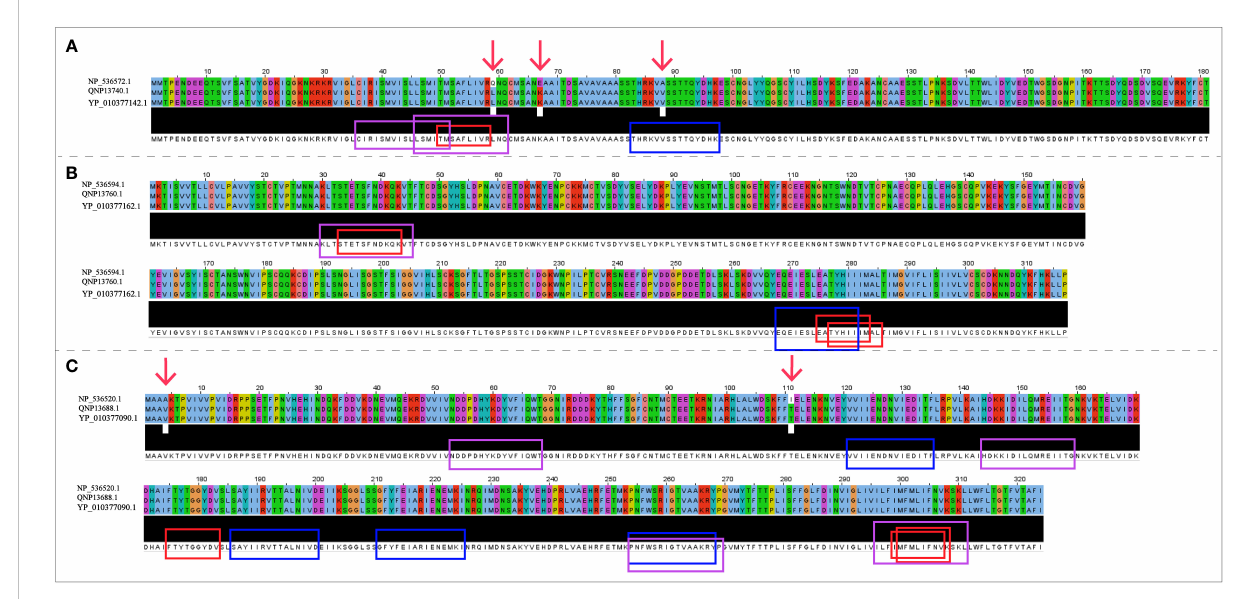
FIGURE 2 The sequence alignment of three target proteins in three selected reference strains. (A) The sequences of A35R; (B) The sequences of B6R; (C) The sequences of H3L; The Zaire-96-I-16 strain is selected as the reference sequence in the sequence alignment, i.e., the fi rst-row sequences were the sequences of Zaire-96-I-16 strain, the second-row sequences were the sequences of MPXV-UK_P2 strain, and the third-row sequences were the sequences of 2022 reference strain. The red arrows refer to mutation sites; The CTL, HTL, and B cell epitopes were highlighted with red, blue and purple box lines in the sequence,